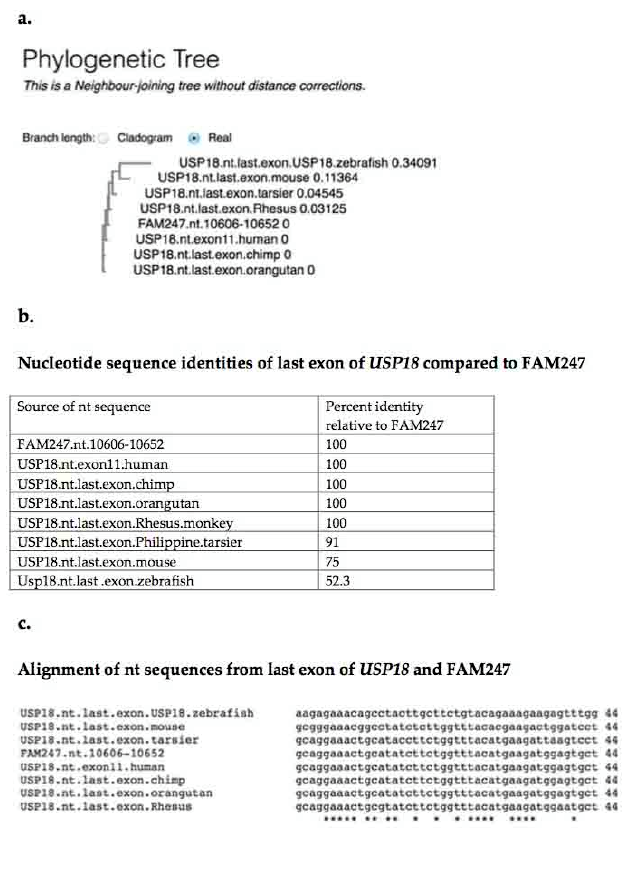
Figure 4. Alignment of the USP18 terminal exon nt sequences from seven species compared with the FAM247 sequence. Data were obtained using the EBI Clustal Omega sequence alignment and phylogeny programs. The EMBL-EBI Clustal Omega Multiple Sequence Alignment program [19] at website http://www.ebi.ac.uk/Tools/msa/clustalo/ was used for nt sequence alignment. ( a ) Phylogenetic tree of USP18 terminal exon sequences from seven species and the FAM247